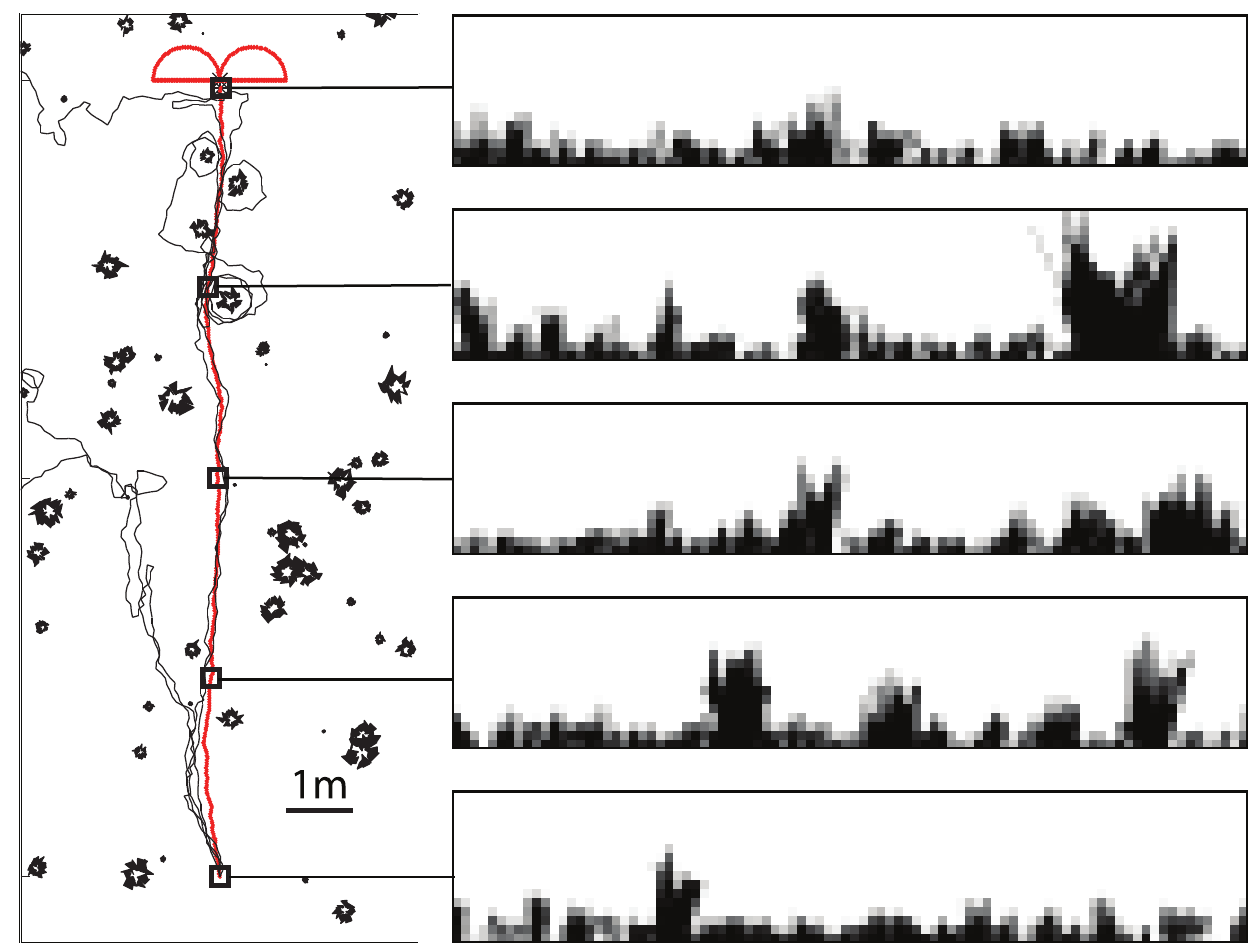
Figure 5. Navigational performance in a cluttered environment with a tussock density of 0.75 tussocks = m 2 . The left panel shows the training (red) and test (black) paths for a 12 m route, squares indicate points where example views from the training run (right panel) are taken from. The combined learning walk and training route consisted of 520 views that were used to train the network.